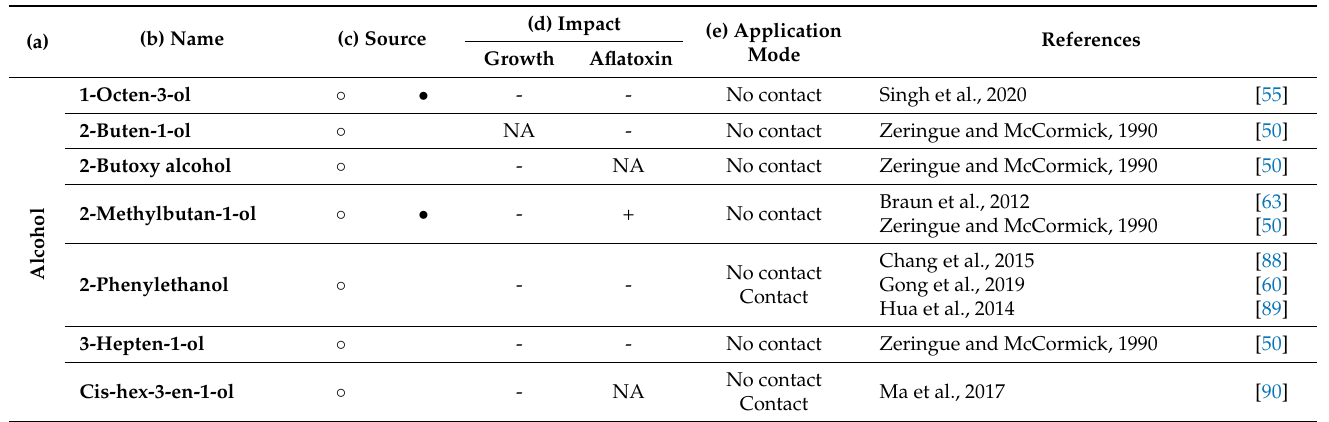
Table 5. Individual VOCs impacting the growth of A. flavus and/or its production of